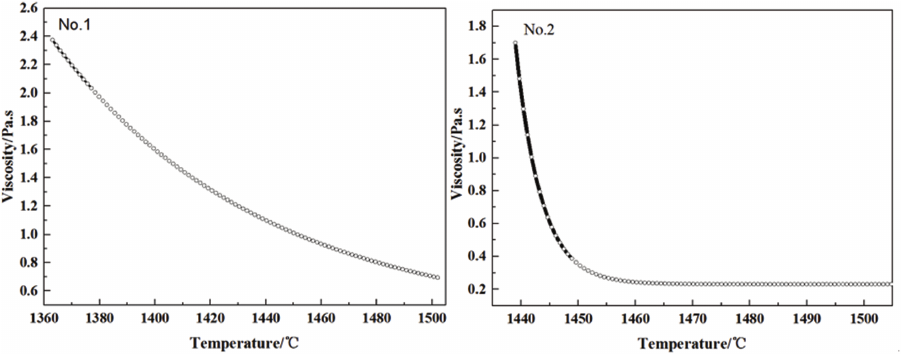
Figure 3: Viscosity curves of the synthetic slags .